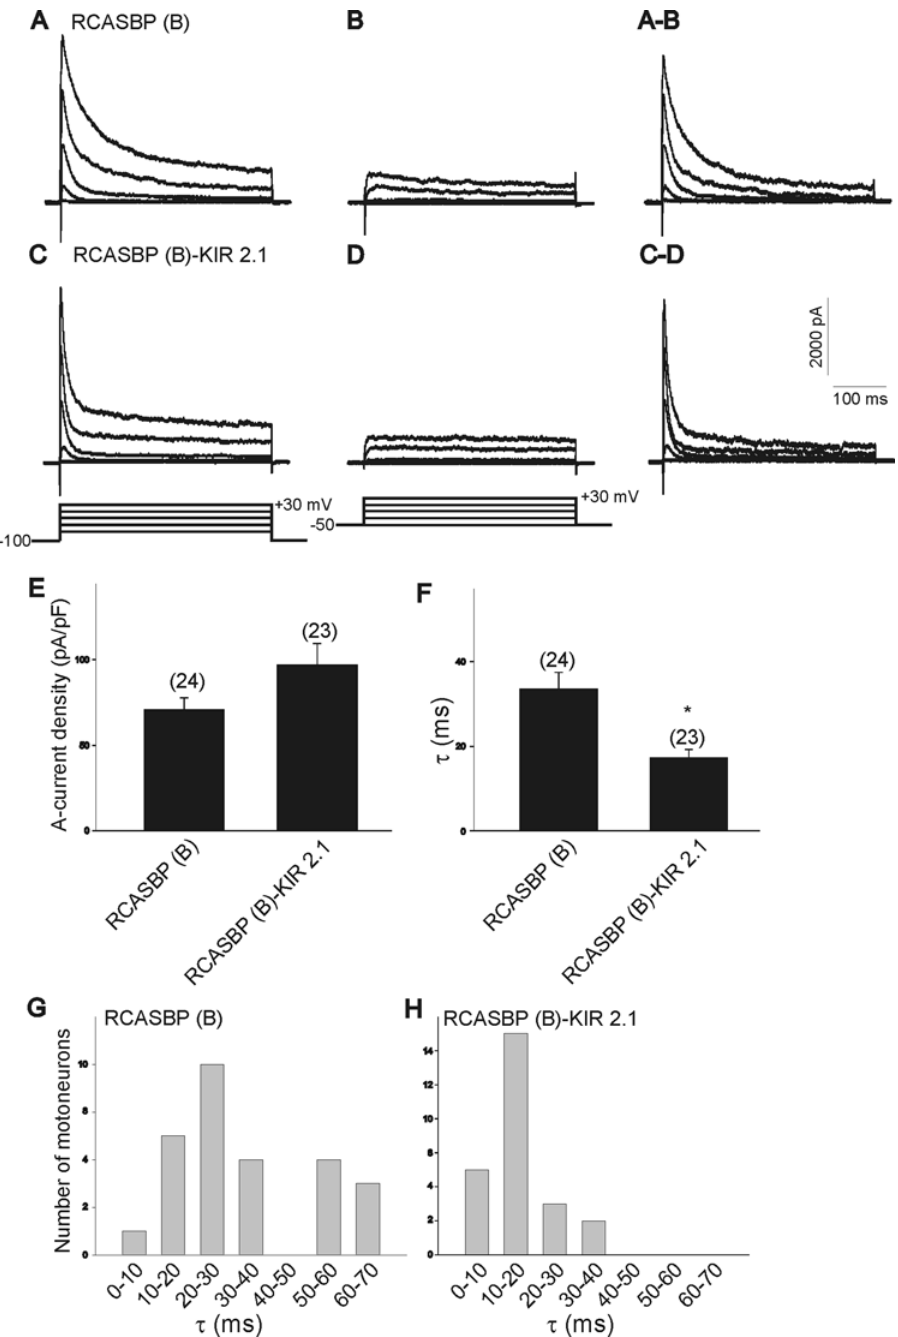
Figure 12. Effect of Kir2.1 expression on the kinetics of A-type K + channels. A–D) Outward K + currents generated in E8 lumbar motoneurons from chicken embryos injected with the RCASBP(B) and RCASBP(B)-Kir2.1 constructs. Outward K + currents were evoked following a series of 10 mV-depolarizing voltage steps from a holding potential of 2 100 mV ( A and C ) or from a holding potential of 2 40 mV ( B and D ). Stimulation protocol used in each case is shown as bottom traces in C and D . Net A-type K + currents were obtained by digital subtraction of traces obtained from 2 100 and 2 40 mV holding potentials ( A–B and C–D ). E) Blockade of spinal cord activity has no significant effect on A-type K + current density ( p =0.08). F) Disruption of spinal cord activity results in a significant reduction in the inactivation time constant of A-type K + currents ( t , p =0.04 vs. RCASBP(B)). G–H) Histograms of inactivation time constants in acutely isolated motoneurons from chicken embryos infected with the RCASBP(B) or RCASBP(B)-Kir2.1 constructs. Changes in A-type K + current density and inactivation time constant were calculated from whole-cell currents evoked by a step pulse to + 10 mV.